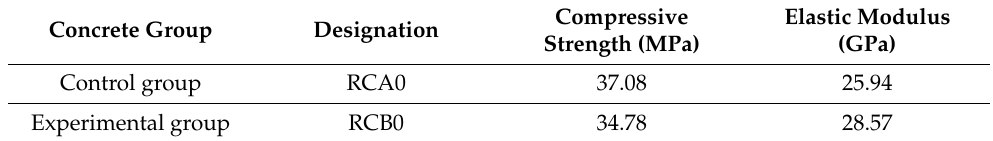
Table 7. Test results of compressive strength and elastic modulus of the concrete at room